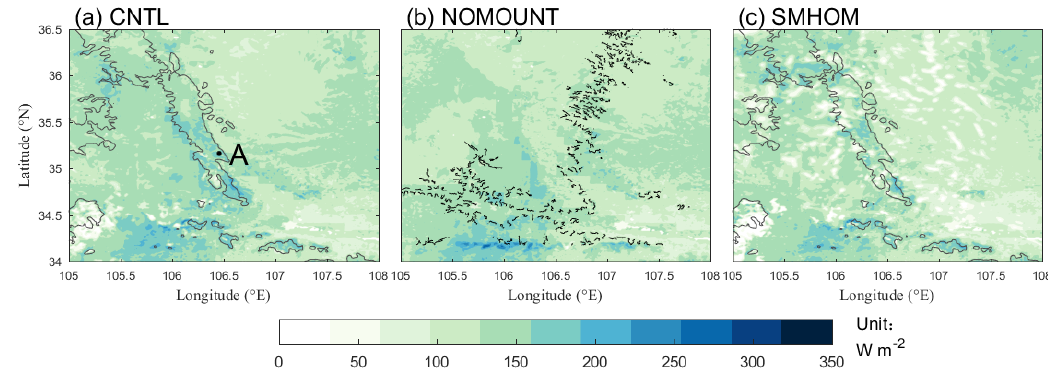
Figure 8. Sensible heat flux (SH, shaded, units: W m −2 ) difference between 0500 and 0800 , ( a ) CNTL, ( b ) NOMOUNT, and ( c ) SMHOM. The solid black lines in ( a ), and ( c ) are 2000 m topographic contours, the black dash line in ( b ) outline the region with removed terrain (1500 m topographic contour) .